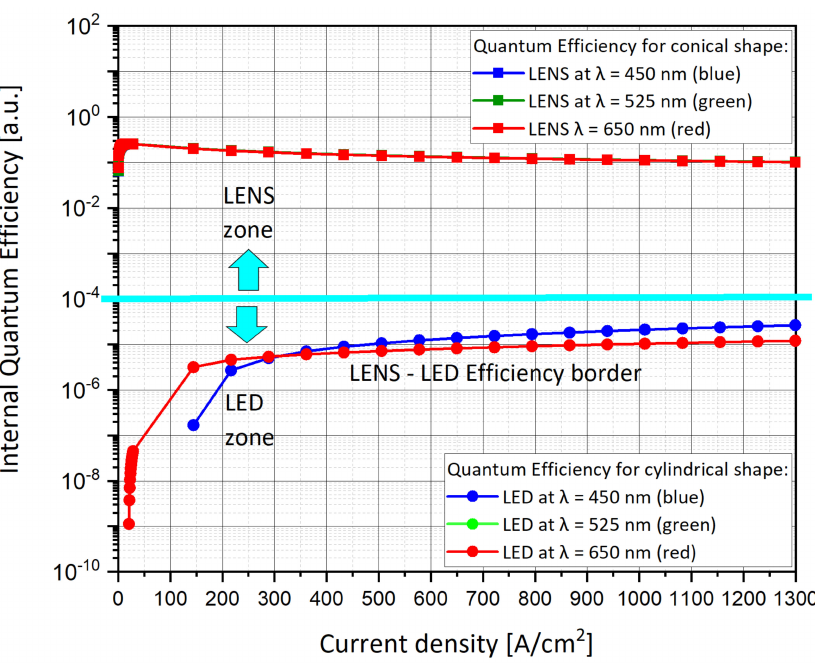
Figure 9. Nano-pixels specification graphs. Efficiency curves for cylindrical device (LED) vs. effi- ciency curves for conical device (LENS). The blue and green LENS curves are overlapping, while the blue and green LED curves are also overlapping.